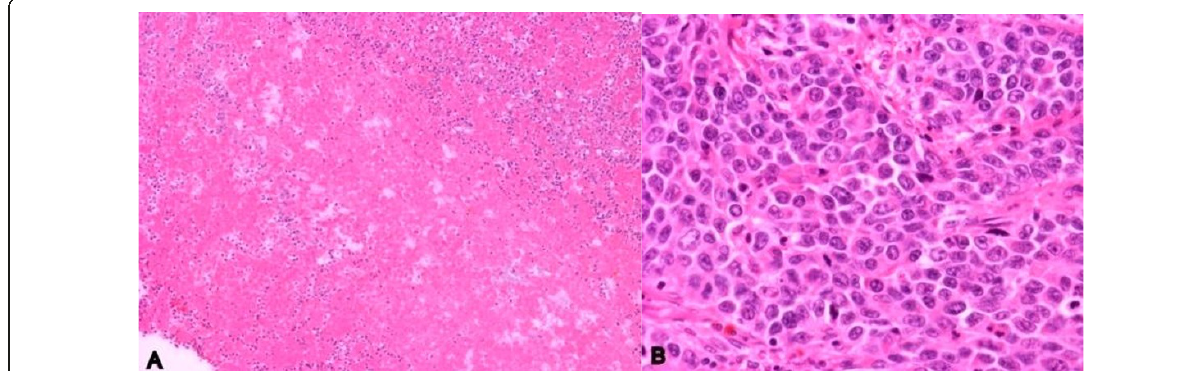
Figure 3 Geographic necrosis can mask underlying GBC . A: Extensive geographic necrosis and prominent acute inflammation (H&E stain, X100), B: The tumor was characterized by vesicular nuclei, prominent nucleoli, and scant eosinophilic cytoplasm (H&E stain,